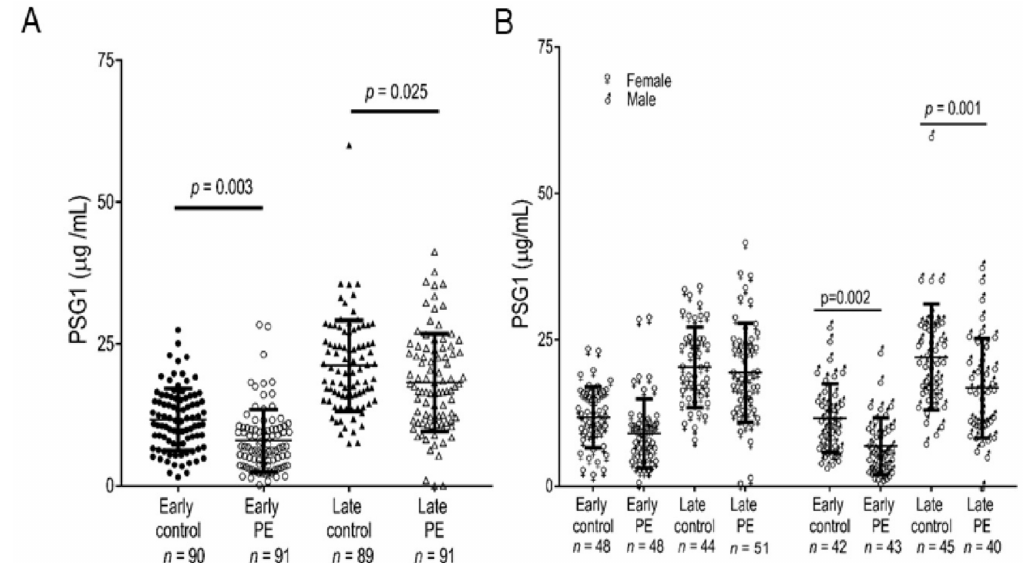
Figure 4. Serum PSG1 concentration is lower in women diagnosed with early-onset and late-onset pre-eclampsia (PE) carrying a male fetus compared to gestational age-matched controls. ( A ) The PSG1 concentration was determined in triplicate in each serum sample using the Quantikine PSG1 ELISA kit. ( B ) PSG1 concentrations shown in A were analyzed considering the gender of the baby. p values